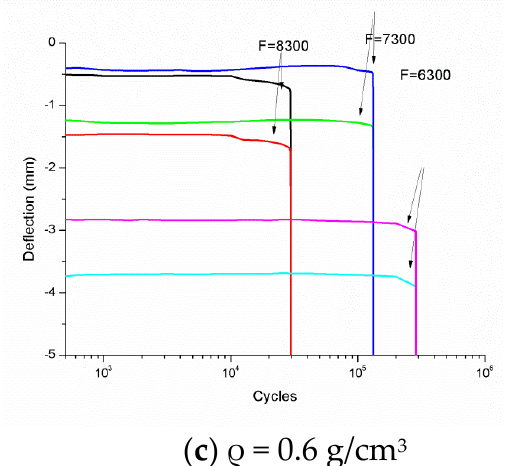
Figure 4. Deflection versus the number of cycles for aluminum foam sandwiches in three-point bending fatigue(( a ) ρ = 0.3 g/cm 3 , ( b ) ρ = 0.4 g/cm 3 , ( c ) ρ = 0.6 g/cm 3 ).